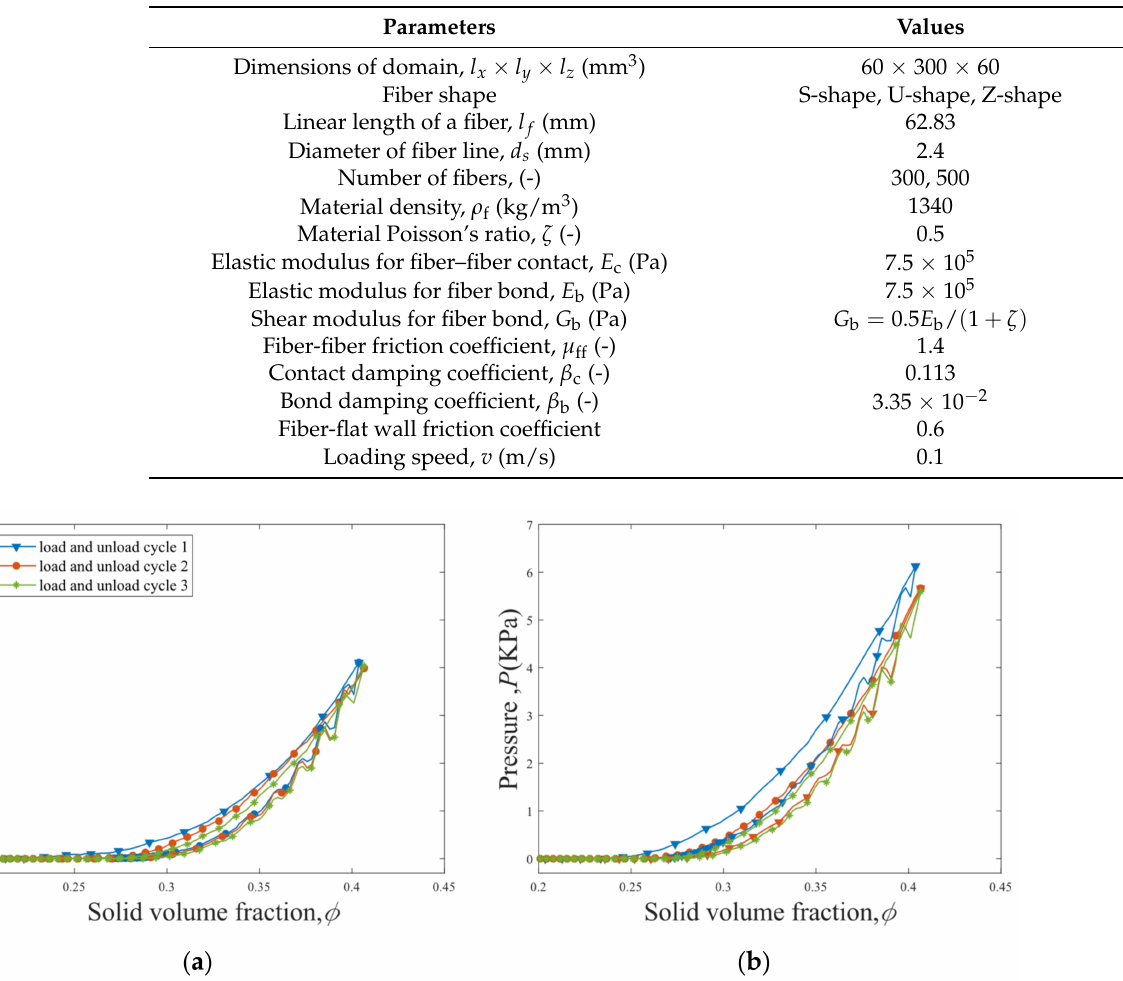
Table 2. The parameters used in the simulations of compression, tensile, and shear tests.